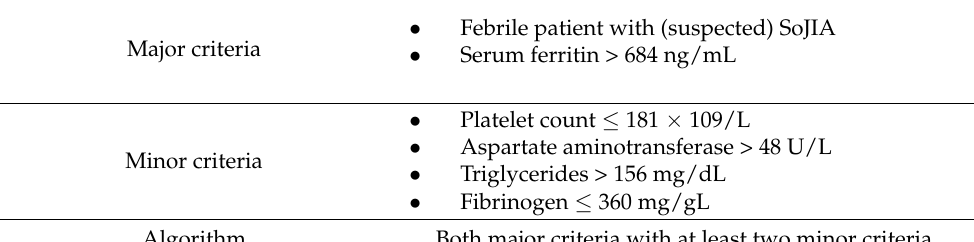
Algorithm Both major criteria with at least two minor